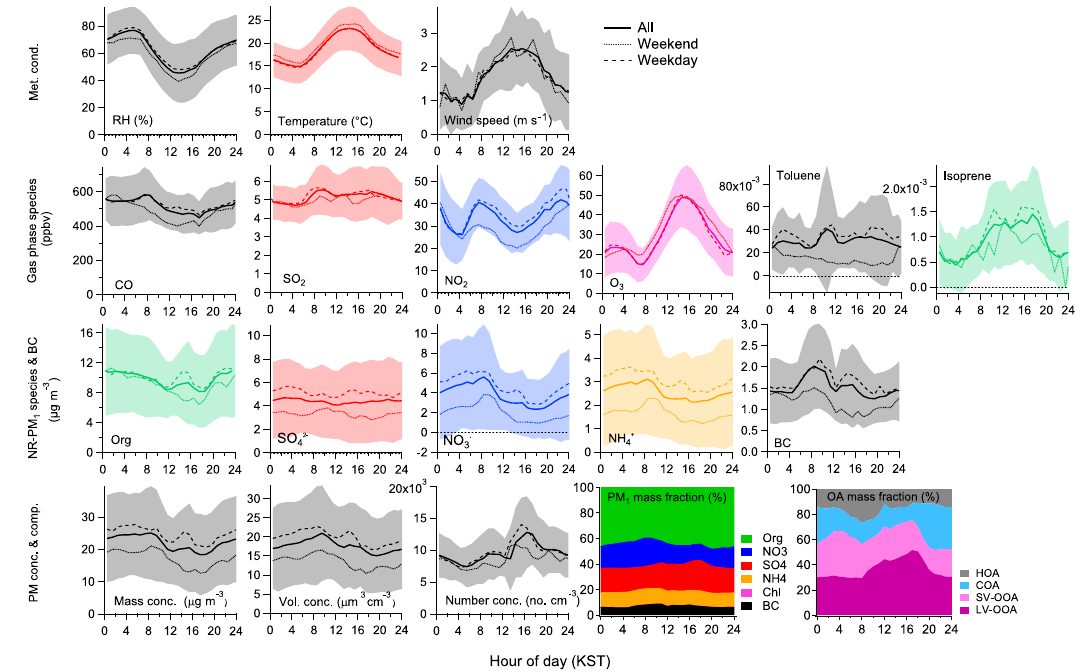
Figure 3. One-hour averaged diurnal profiles for the various meteorological parameters (a) , gas-phase species (b) , PM 1 species (c) and PM mass concentration, volume concentration, and number concentration (d) . Two of the figures (e, f) show the fraction of PM 1 mass and organic mass, respectively.